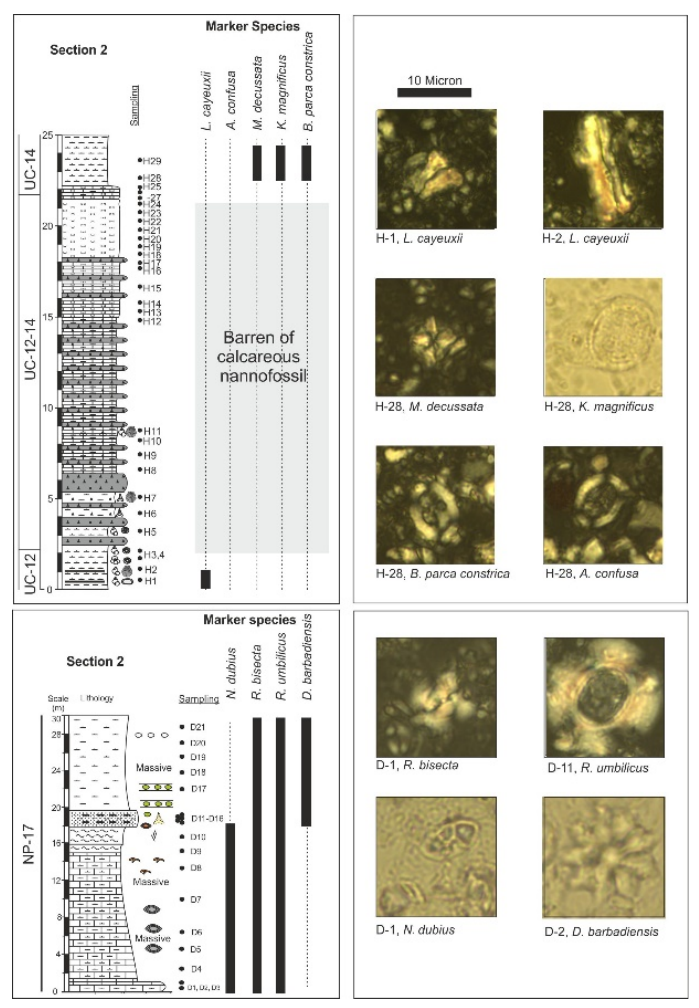
Figure 4. Distribution charts of marker species of calcareous nannofossils in sections 1 and 2. L. Cayeuxii , the marker species of biozone UC-12, B. parca constrica, the marker species for UC 14, and R. bisecta , the marker species for NP17 are illustrated in the plates.